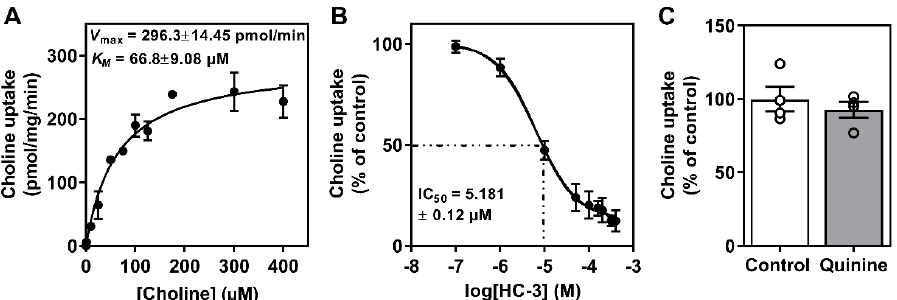
Figure 1. Characterization of Huh7.5 cell choline uptake. ( A ) Choline uptake saturation kinetics fit to a Michaelis-Menten curve. ( B ) Inhibition of choline uptake in response to hemicholinium-3 (HC3). ( C ) Choline uptake inhibition in response to 200 µ M quinine (OCT inhibitor). Data are mean ± SEM and represent 3–4 independent experiments.